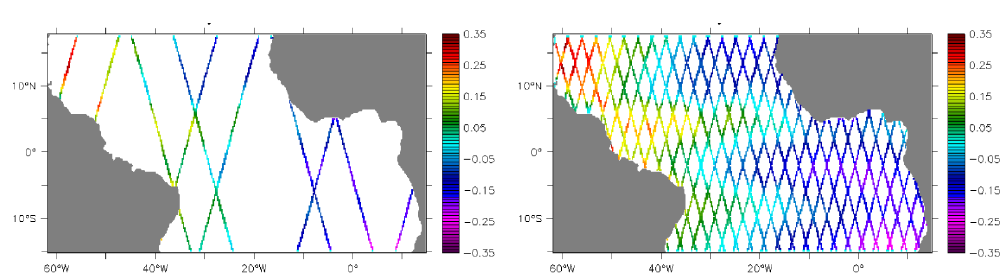
Fig. 2. Horizontal distributions of in situ observation network simulated for the experiment. Left: observations available for one assimilation step (here: 30 June 2005). Right: observations coverage after 18days.